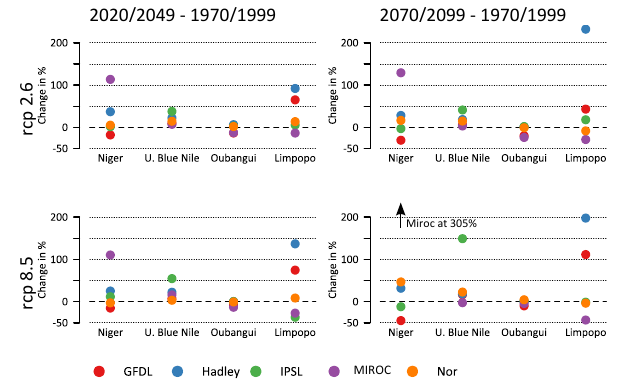
Fig. 9. Change in Q 10 (high flows) of five bias corrected model projections in near (2020–2049, left column) and far (2070–2099, right column) scenario periods compared to the reference period (1970–1999) for RCP 2.6 (upper row) and RCP 8.5 (lower row) in percent.